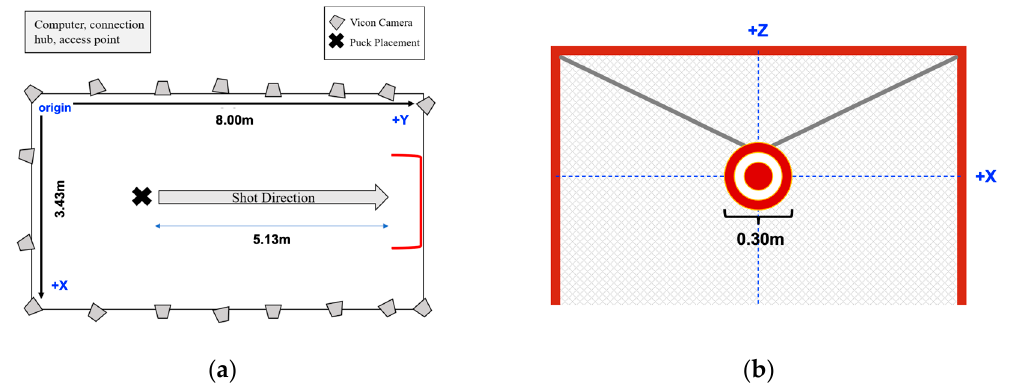
Figure 1. Schematic of the Biomechanics and Performance Analysis Lab layout: ( a ) top view of the motion capture area during data collection; and ( b ) net view, including the 0.30 m circular target— suspended in the center of the net using rope—which participants aimed for during each trial.